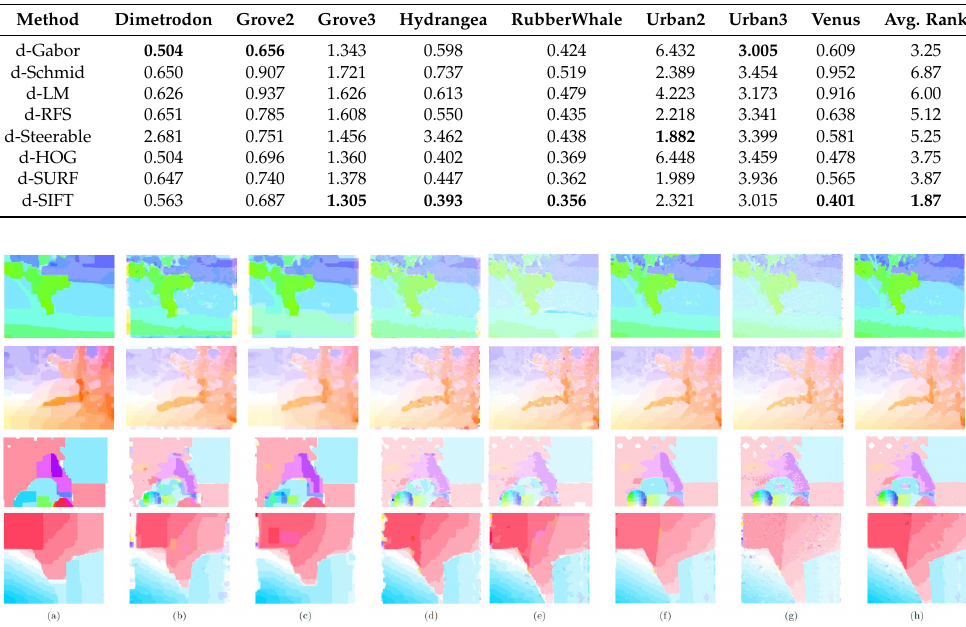
Figure 5. Sample results of the optical flow estimation for Grove2 (first row), Grove3 (second row), RubberWhale (third row) and Venus (fourth row) using the eight dense descriptors, d-Gabor ( a